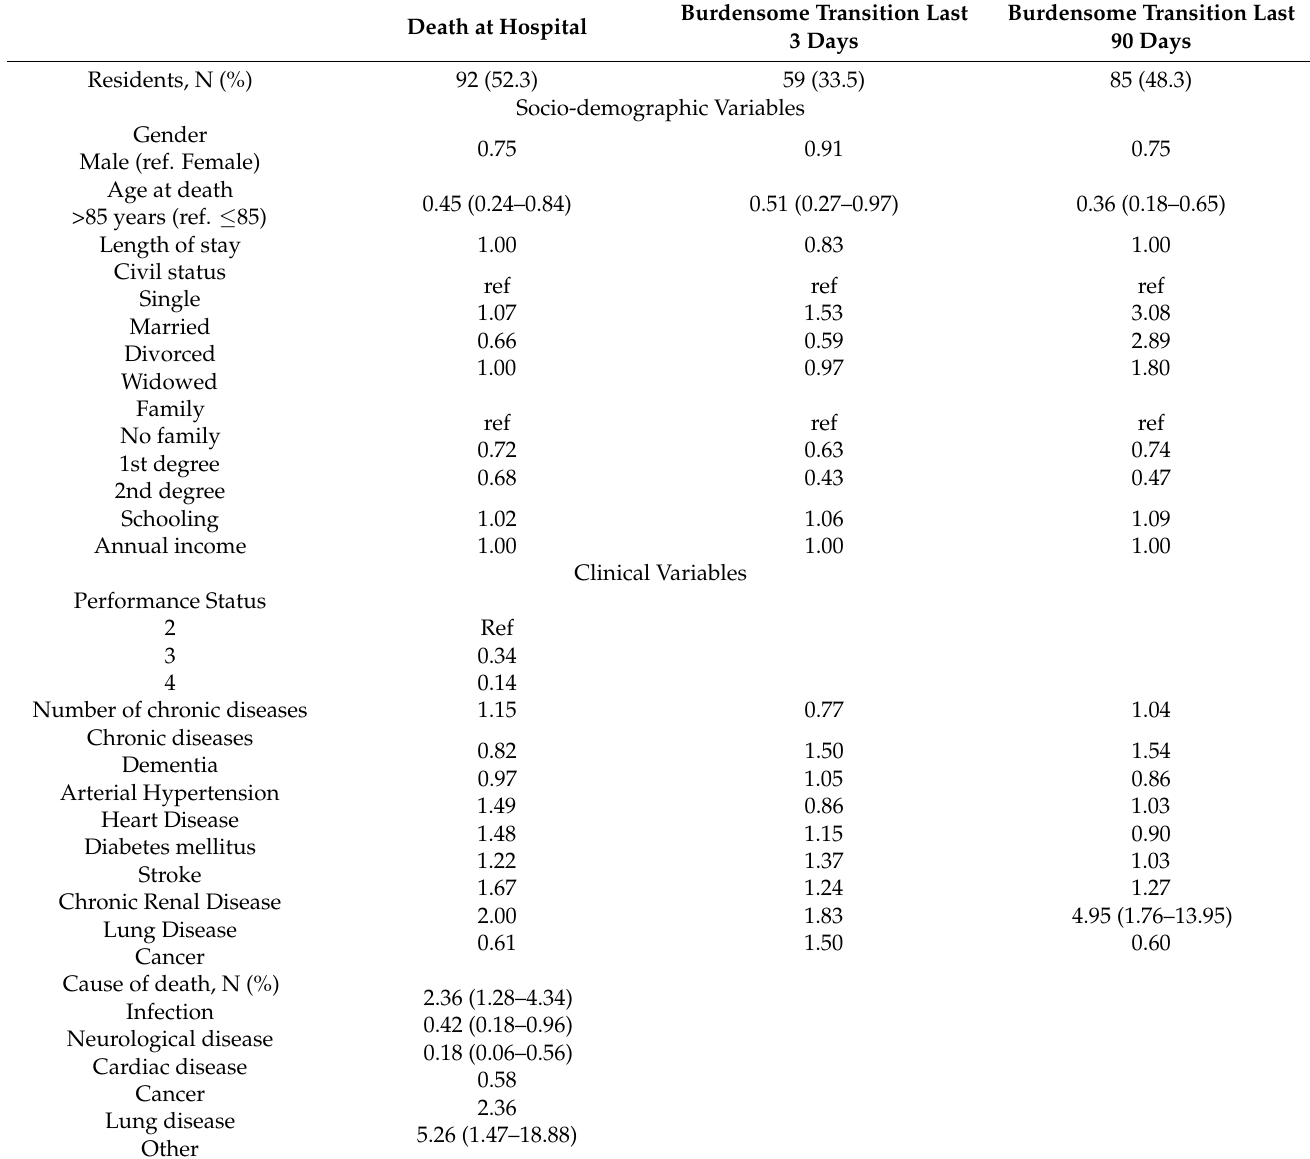
Table 3. Predictors of death at Hospital and potentially Burdensome Transitions. (OR, OR (95% CI) if p < 0.05). N—number; Ref—reference, LTCF—Institution with Long Term Care Facility. Burdensome Transition Last Burdensome Transition Last Death at Hospital 3 Days 90